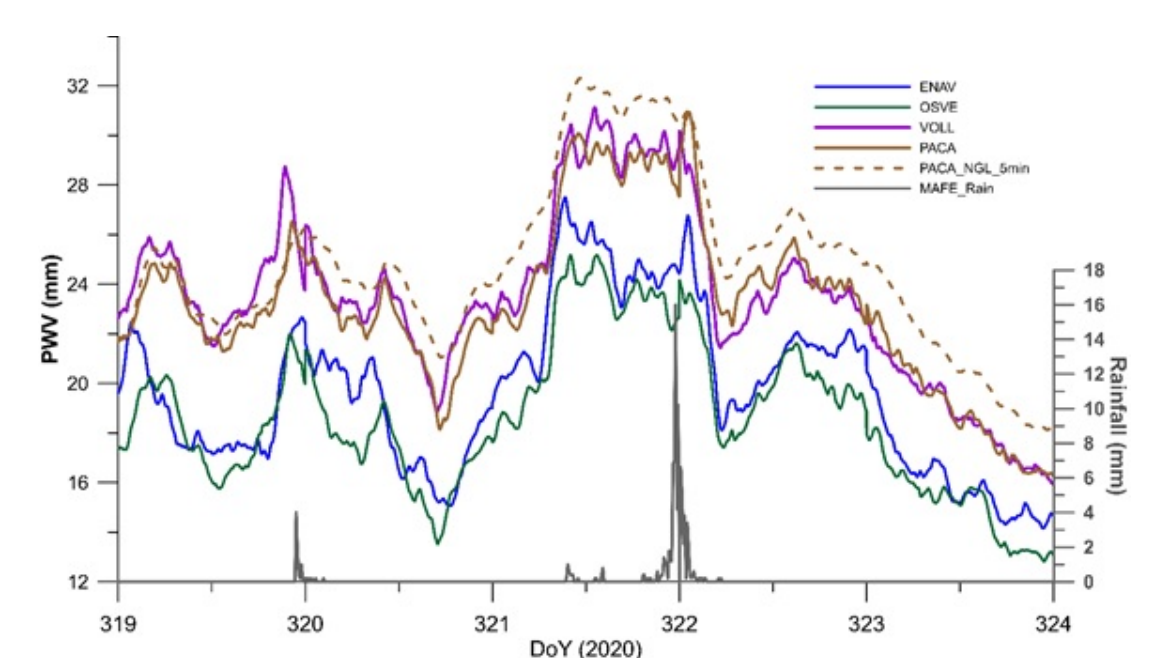
Figure 10. Thirty-second values of PWV, obtained with CRS-PPP analysis, for a selection of stations of NeVoCGPS network located at different heights and rainfall amounts (grey curve); NGL and Gamit solutions for TAI1 and MAFE stations, respectively, are also plotted too a reference.